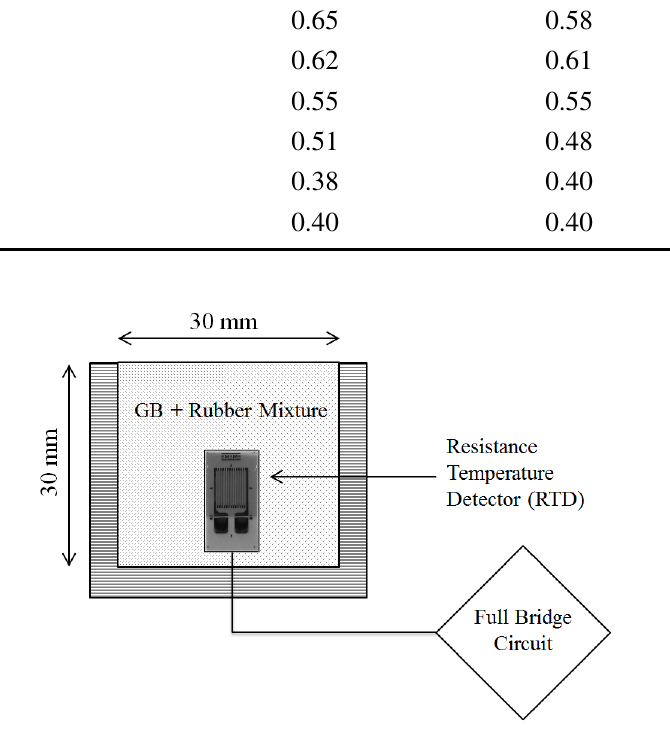
Figure 1. Experimental configuration for measuring thermal conductivity of granular mixtures. The transient plane source method embedded within the specimen is implemented to measure thermal